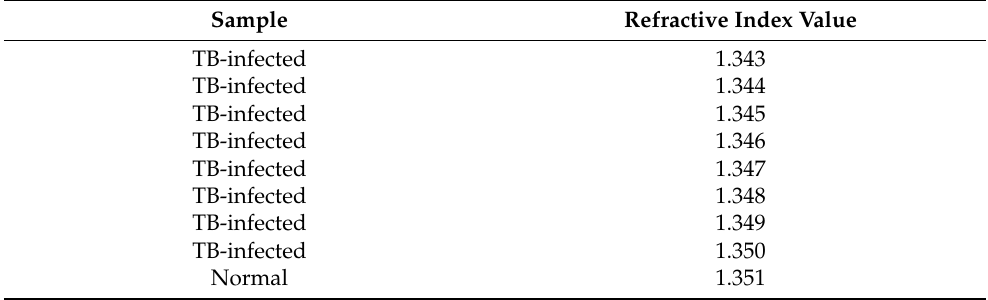
Table 2. The refractive index of normal and TB-infected blood plasma samples obtained from